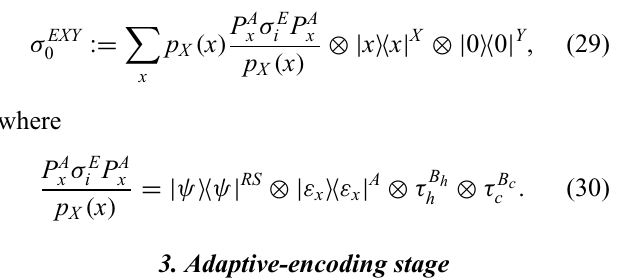
FIG. 2. The circuit description of the QEC engine. Lines locally disconnected from channels imply that the global channel (at that time step) has the effect of a local identity operation on the corresponding systems. We emphasize that the internal Hamiltonian of the = H R ≡ 0. All other (local and interaction) reference system is assumed to be trivially zero at the initial and final times, namely H R i f Hamiltonians are assumed to be cyclic, i.e., H i = H f . The only nonunitary steps in our engine are the error-syndrome measurement } (characterized by the quantum instrument { N SA y for a given x ) and the discarding (memory erasure) of the classical registers X and Y . y | x = | ε (cid:11)(cid:12) ε | A ) and hence the nonselective (i.e., P A x x x